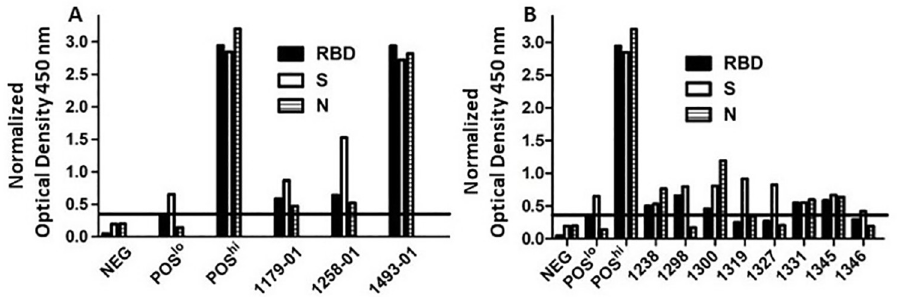
Fig 1. Detection of SARS-CoV-2 specific antibodies. Plasma samples collected from study volunteers were tested by ELISA against SARS-CoV-2 RBD, full length S protein and N protein. Panel A shows results with plasma from three representative subjects with confirmed COVID-19 infection along with negative, high positive and low positive control samples. Panel B shows results from eight study subjects without a PCR-based confirmatory test. The horizontal line represents the cutoff value for positivity based on reactivity with S or RBD for plasma samples collected from healthy control volunteers prior to October, 2019. The cutoff value was set at two standard deviations above the mean optical density of the plasma samples collected from healthy control volunteers prior to October, 2019. Optical density readings were normalized against the level of the high positive standard run on each ELISA.